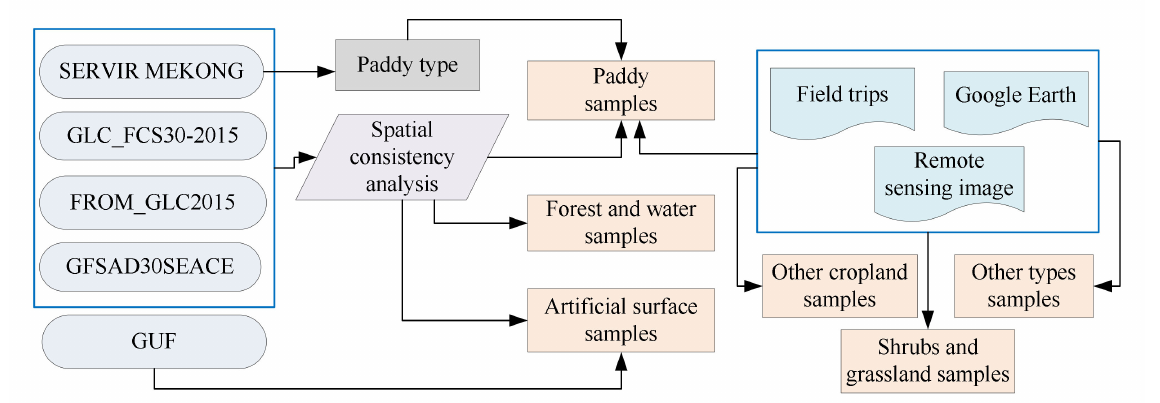
Figure 5. The flowchart of the process of obtaining the training